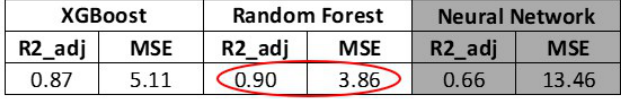
Figure 19. Comparison of results between different